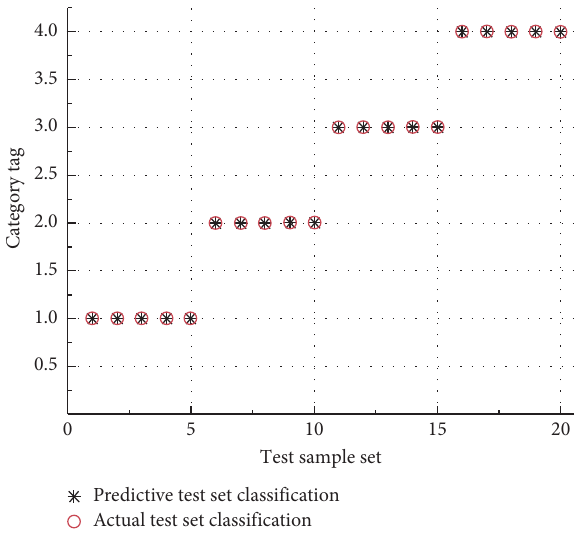
Figure 15: The classification prediction result.